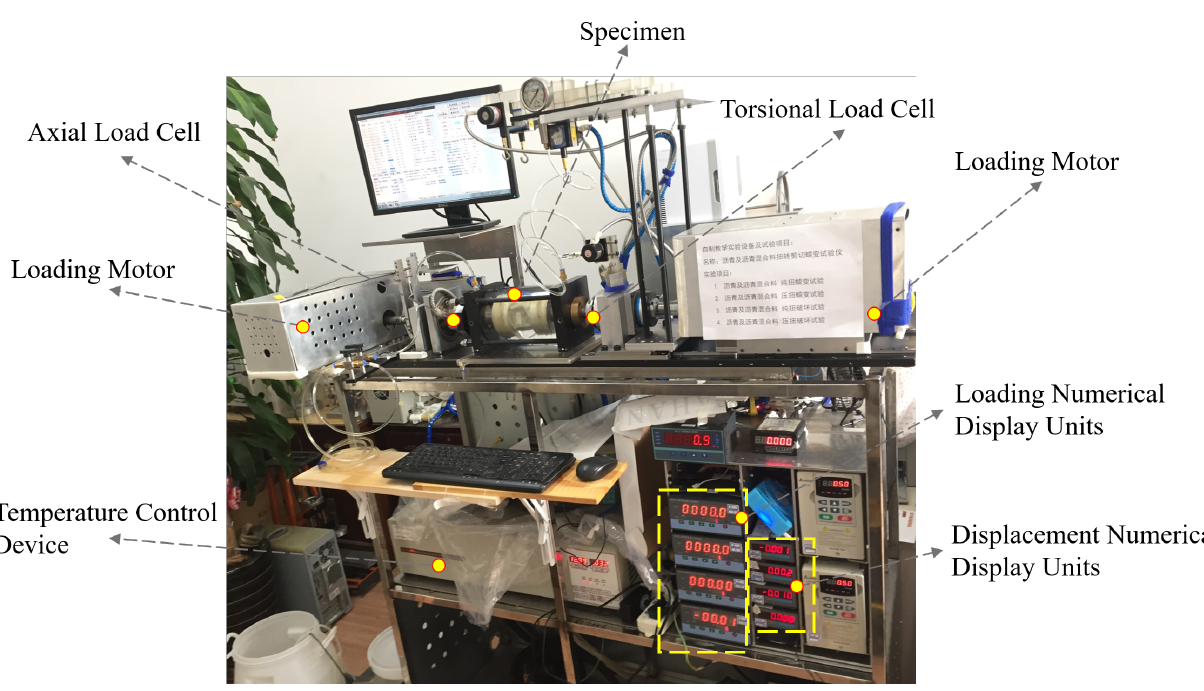
Figure 1. The torsional shear testing